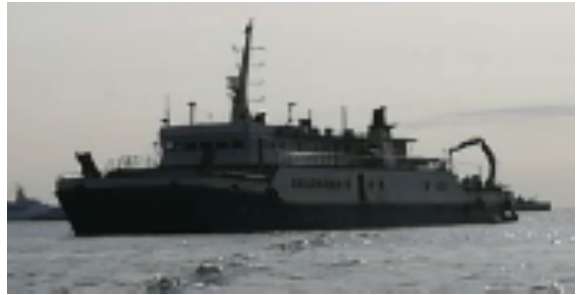
Figure 2. Photo of the experimental